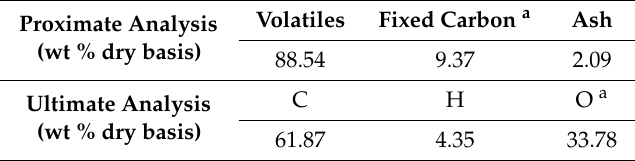
Table 1. Proximate and ultimate analysis of poly (ethylene terephthalate) (PET). Proximate